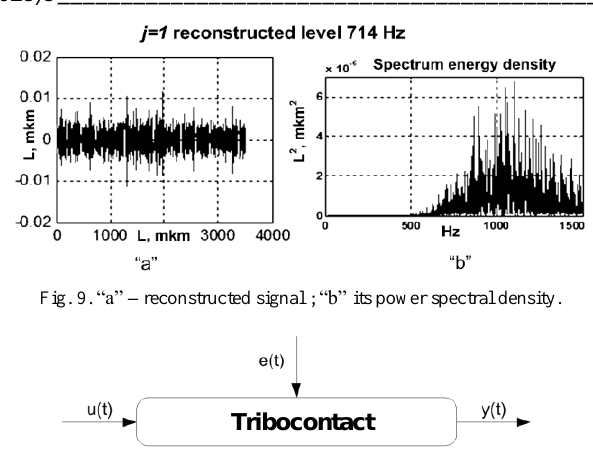
Fig. 9. “a” – reconstructed signal ; “b” its power spectral density.